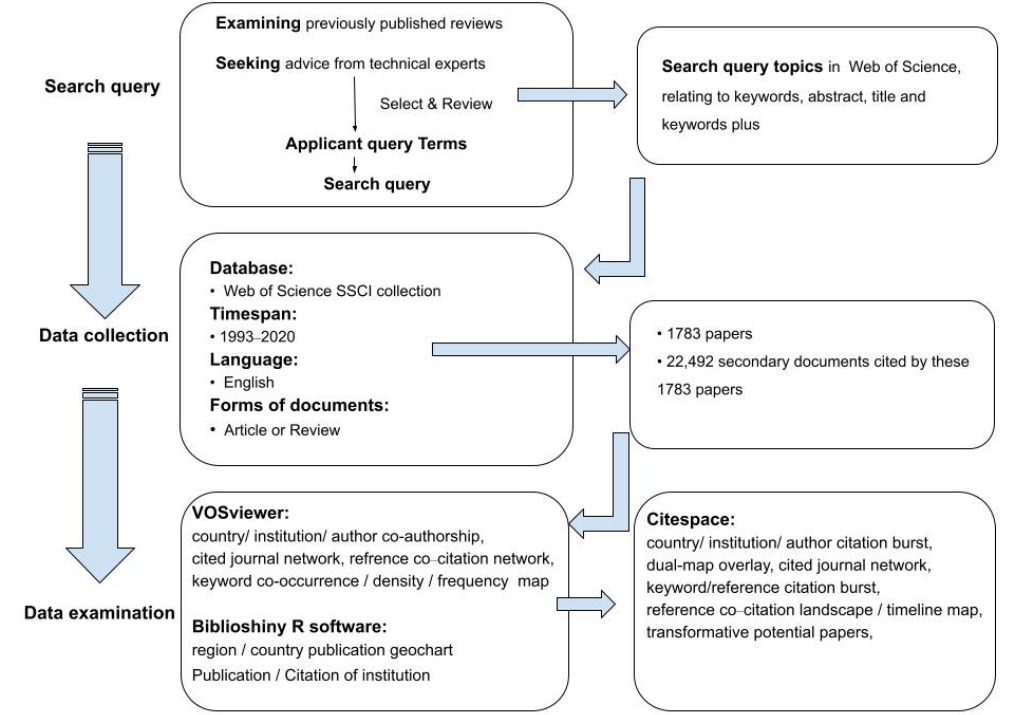
Figure 1. Integrated research mapping workflow. Table 1. Results from a selection of search methods.